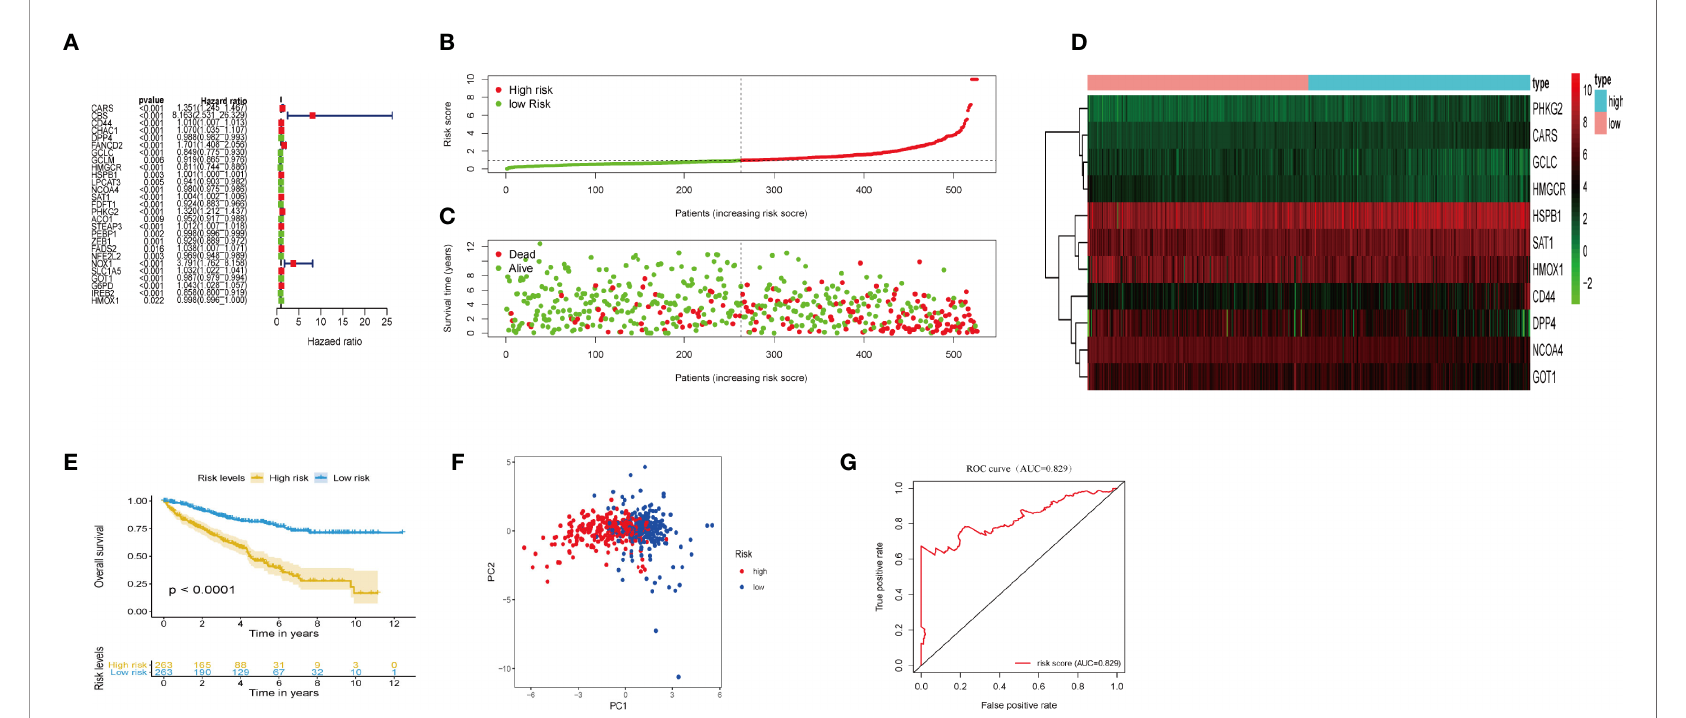
FIGURE 1 | Construction and validation of the ferroptosis-related genes prognostic signature in ccRCC patients. (A) Univariate Cox regression analysis showed that 27 ferroptosis-related genes were related to the overall survival rate (OS) of ccRCC patients. (B) Distribution of risk scores of high- and low-risk BCLA patients based on the ferroptosis-related genes prognostic signature. (C) The scatter plot showed the correlation between the survival status of high- and low-risk ccRCC patients. (D) The heat map showed the differences in the expression of 11 ferroptosis-related genes between high and low risk patients. (E) Kaplan – Meier survival curve showed that the survival time of the high-risk group was signi fi cantly shorter than that of the low-risk score group. (F) PCA showed that 11 ferroptosis-related genes were distributed differently between high-risk groups and low-risk groups. (G) ROC curve analysis of risk score as an independent prognostic